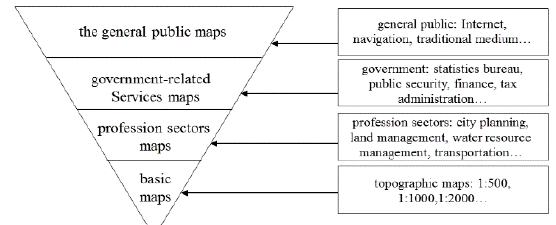
Figure 1. Changes in map and geographic information users